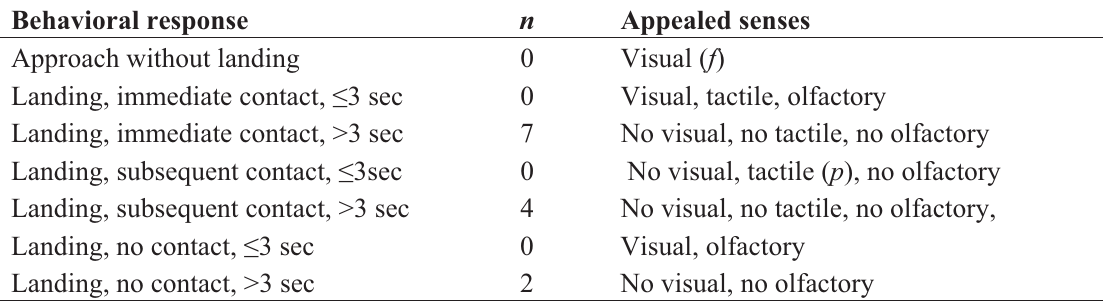
Table 1. Number of behavioral responses of feral pigeons to the tested optical gel on